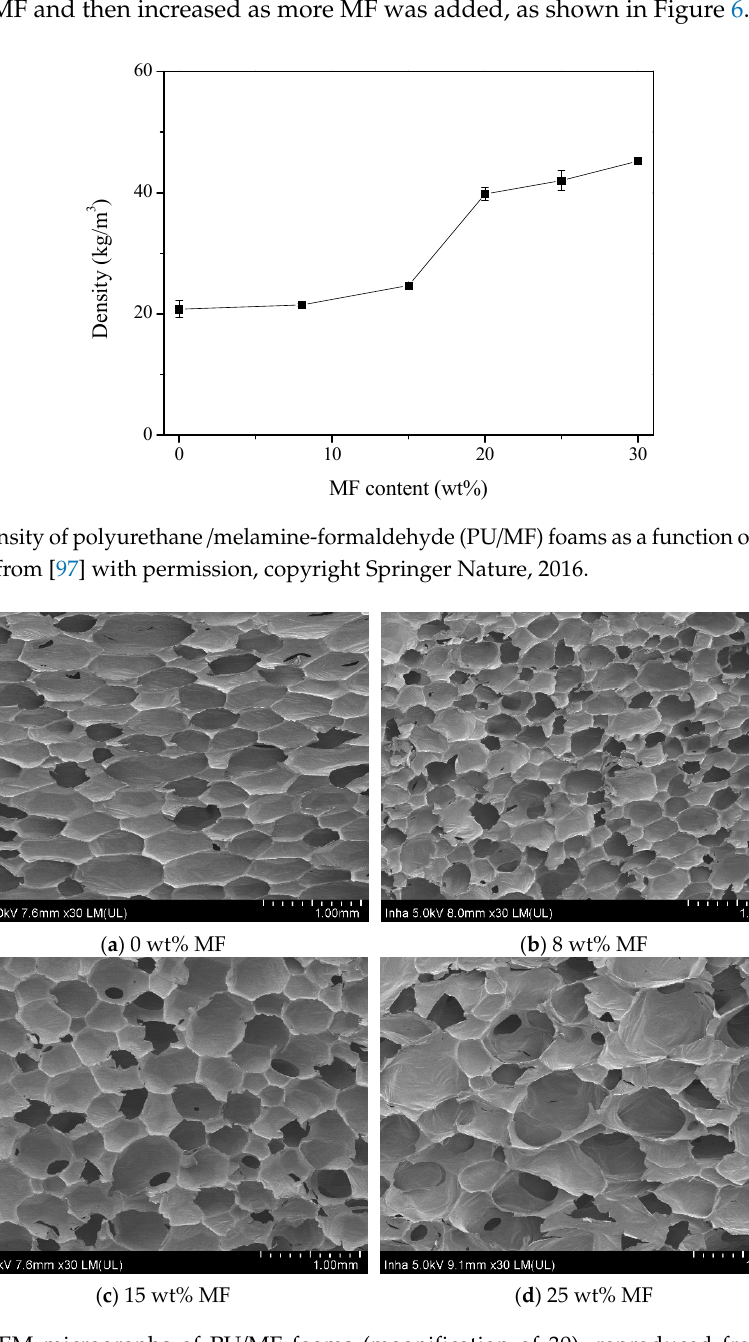
Figure 6. SEM micrographs of PU/MF foams (magnification of 30), reproduced from [97] with permission, copyright Springer Nature, 2016.